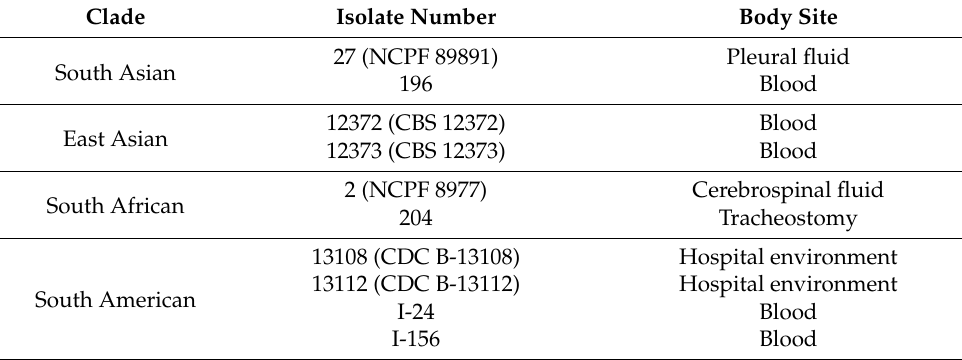
Table 1. Characteristics of Candida auris isolates used in the study.